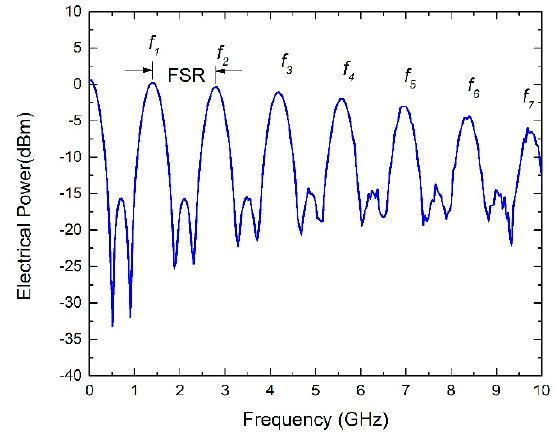
Figure 9. RF spectrum at the output of the upper arm simulated by VPIphotonics [10].